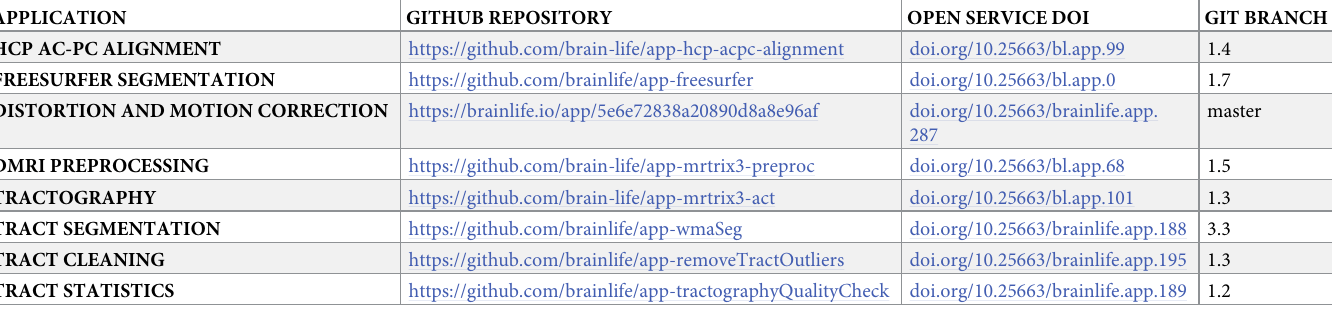
Table 1. Data, description of analyses, and web-links to the open source code and open cloud services used in the creation of this dataset can be viewed in their entirety here: